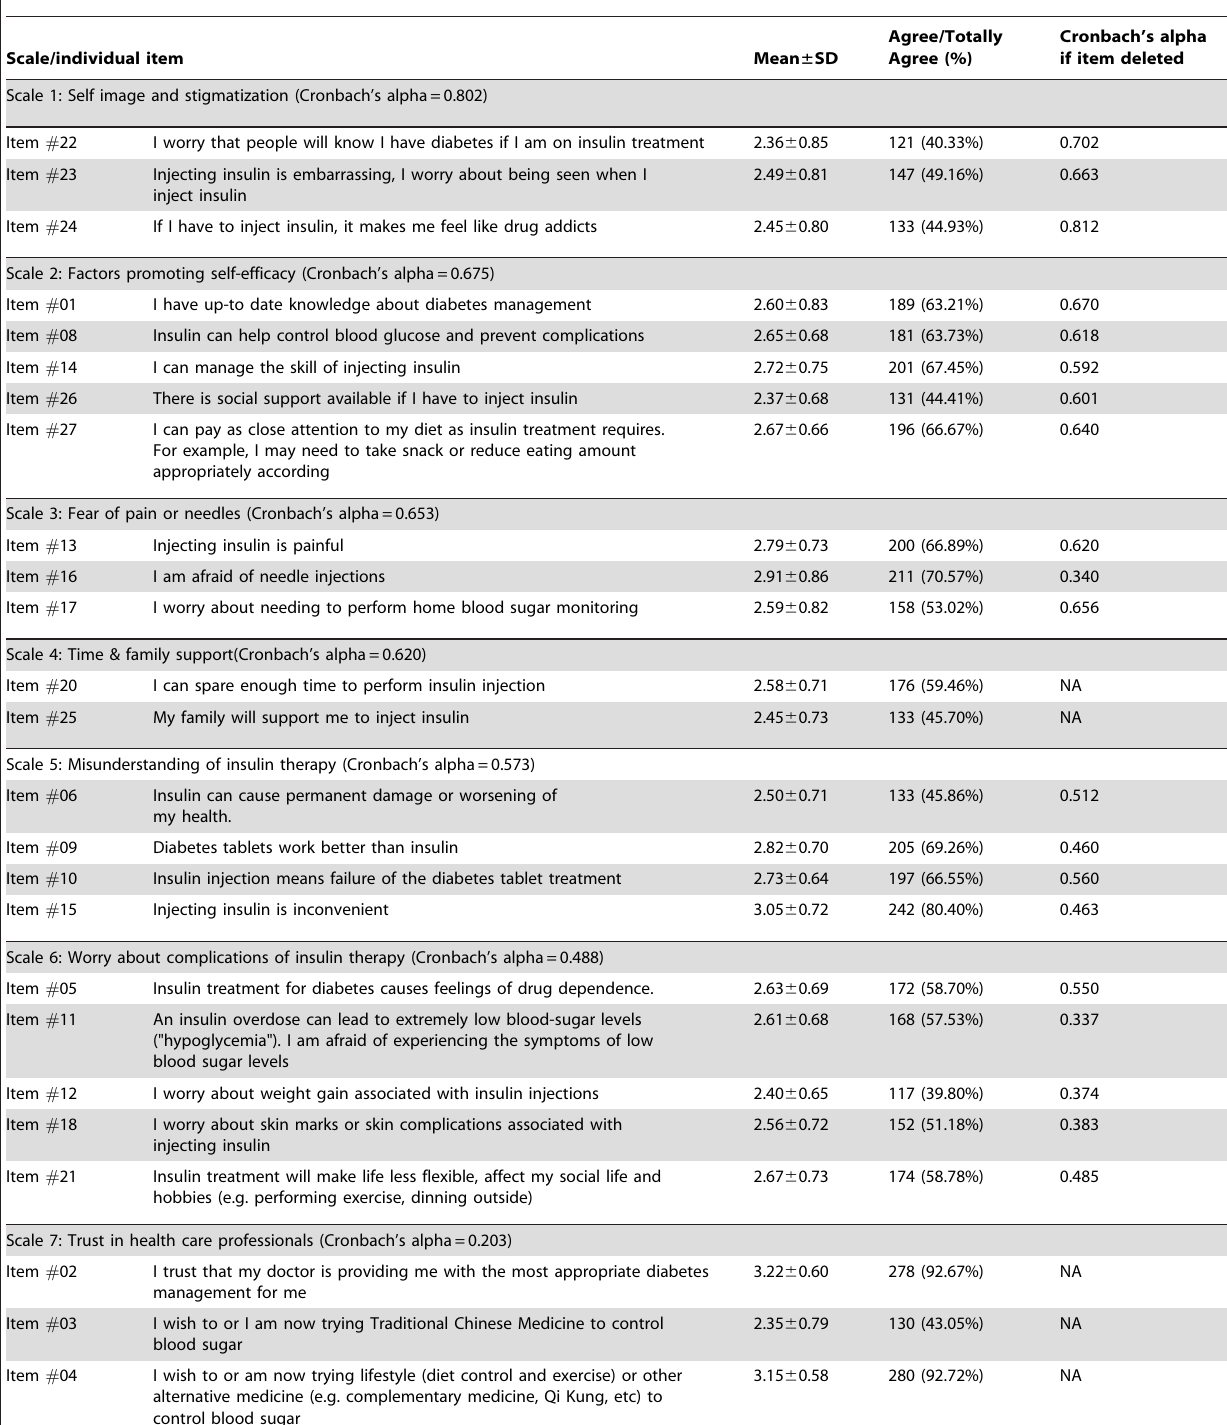
Table 4. Mean scores and distribution of responses to individual items, and Internal consistency for each scale.